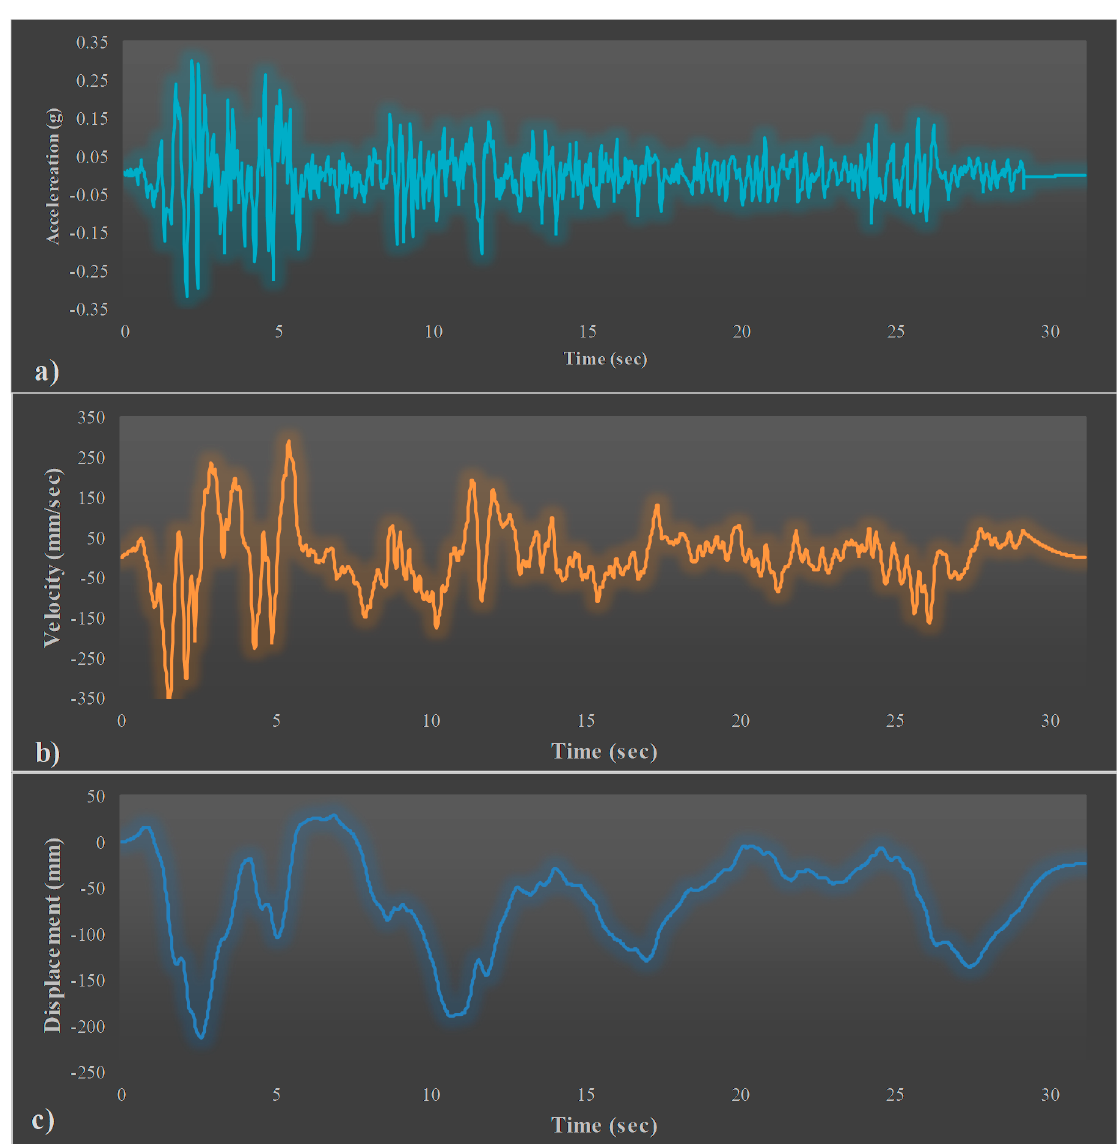
Figure 4. Time histories of the north-south component of the 1940 El Centro ground motion: ( a ) acceleration, ( b ) velocity, and ( c ) displacement.